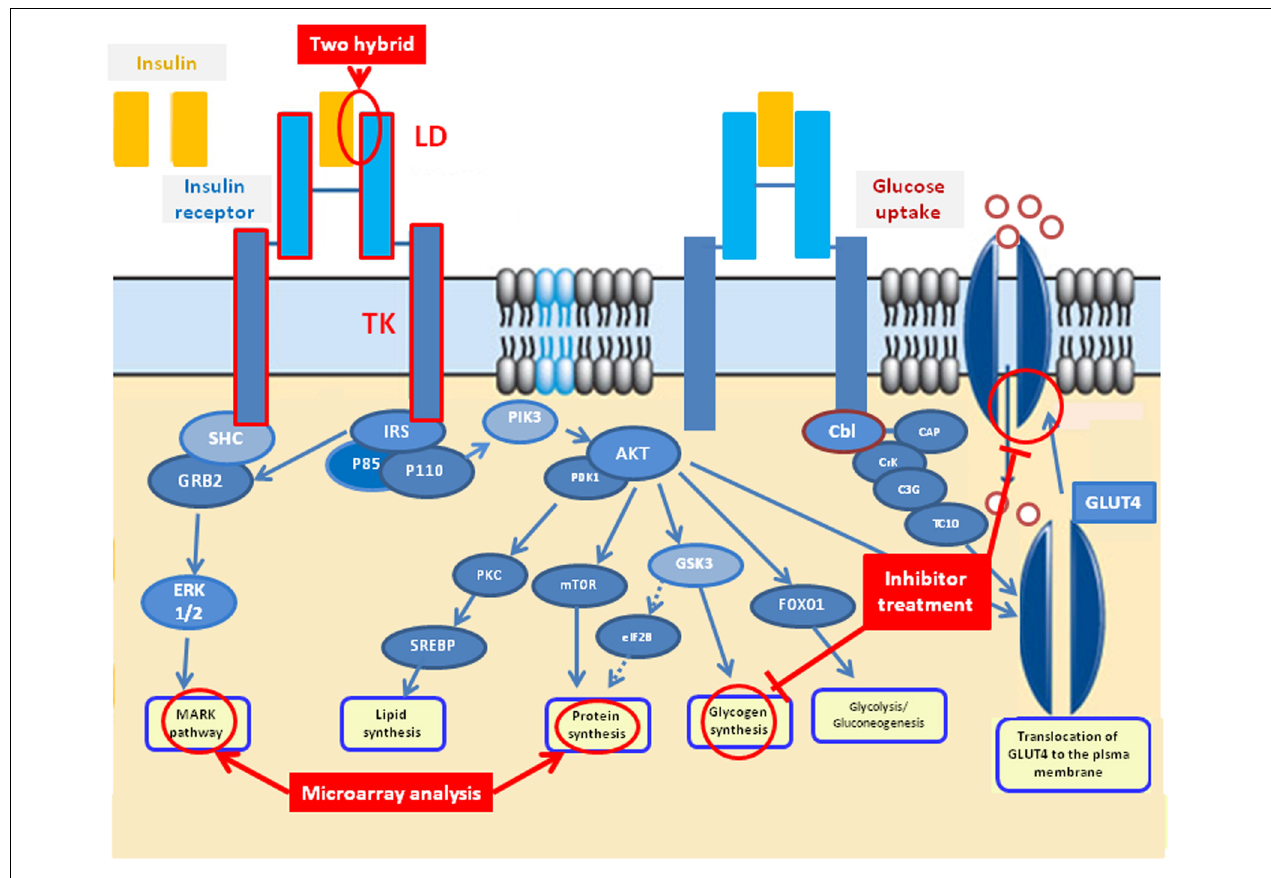
FIGURE 1 | Predicted insulin signaling pathway in schistosomes based on the characterization of schistosome insulin receptors,